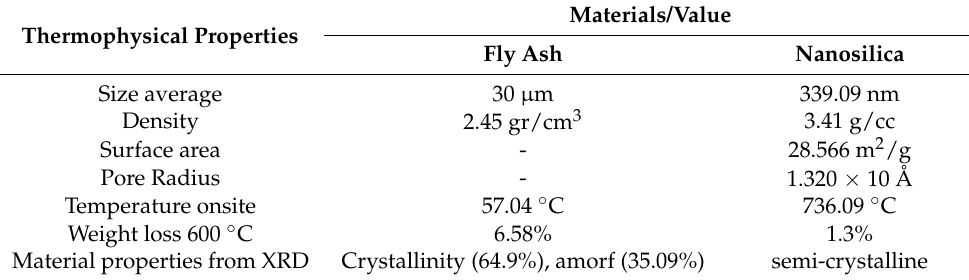
Table 2. Thermophysical properties of materials.